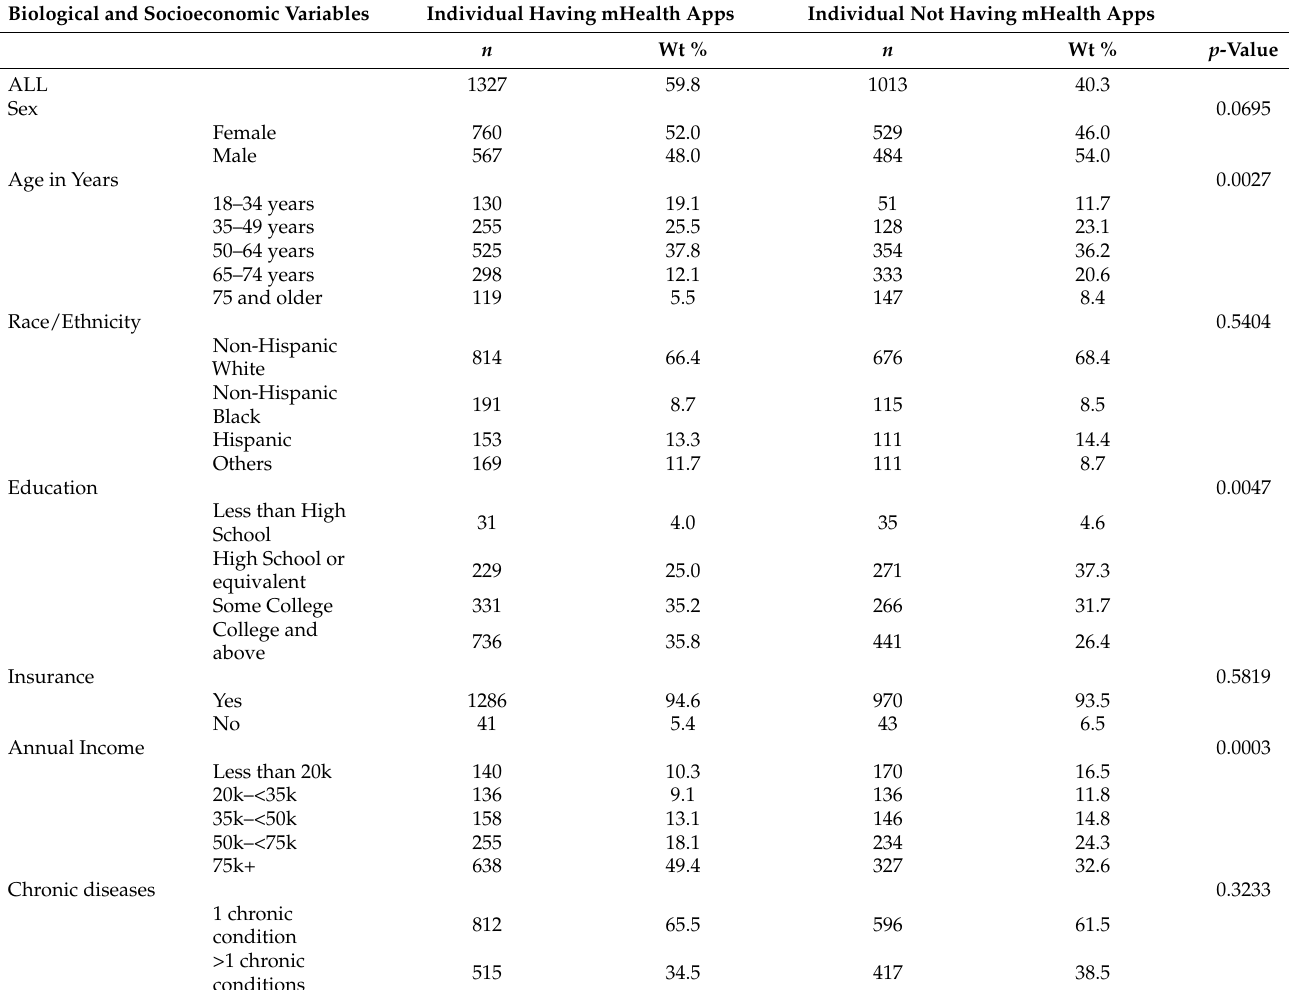
Table 1. Biological and Socioeconomic Characteristics of the Study Sample by Individuals Having Mobile Health Applica- tions (Health Information National Trends Survey-5, Cycle 2 and 3). Biological and Socioeconomic